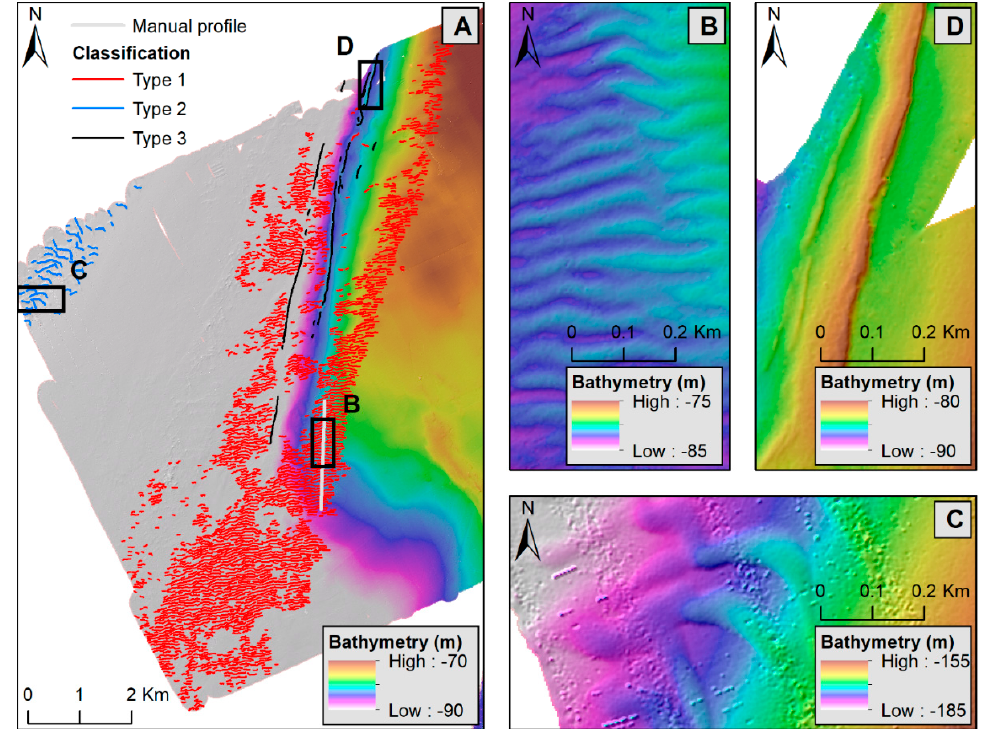
Figure 14. Point Cloates area classification ( A ). Three types of bedforms were discriminated using the metrics (see Figure 14) referred to as Type 1 ( B ), Type 2 ( C ) and Type 3 ( D ). The grey line indicates the position of the manual profile used to compare manual and automated metrics.